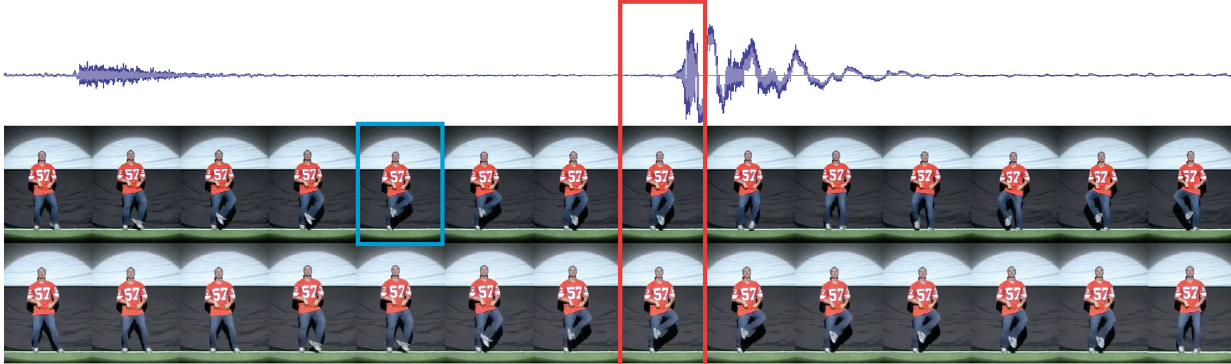
Fig. 1 A music signal (above), and a sequence of frames from both the input video (middle) and output video (below); the music beat is marked by a red frame. The output video is synchronized with the music beat, while in the input video, the motion beat, marked by a blue frame, occurs 3 frames before the music